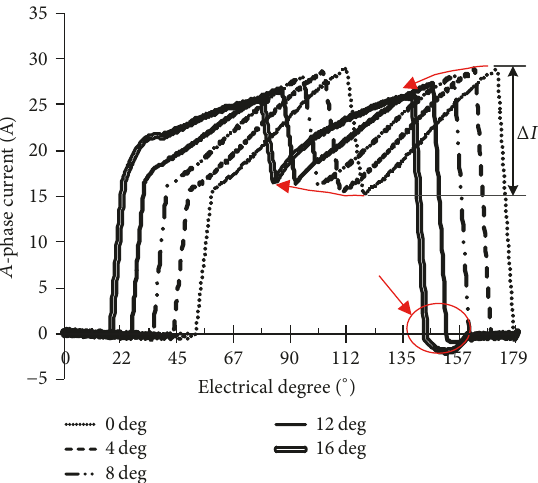
Figure 4: The phase currents varying with the advanced angles within half electrical